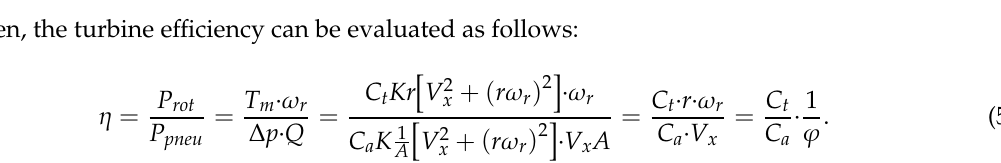
Table 1 resumes the parameters set for the Simulink model of di ff erent turbines: Wells, Dennis-Auld, and Impulse. Table 1. Parameters of the turbines modeled for the tests.